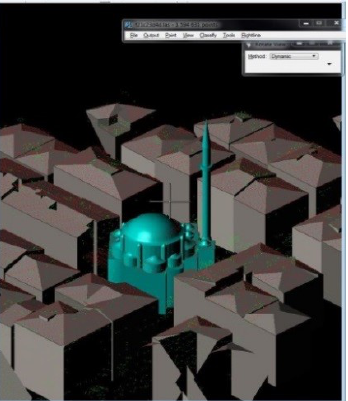
Figure 8: Manual digitizing of complex building Figure 9 and 10 illustrate the model of the city model created from manual drawings and editing of the roofs.